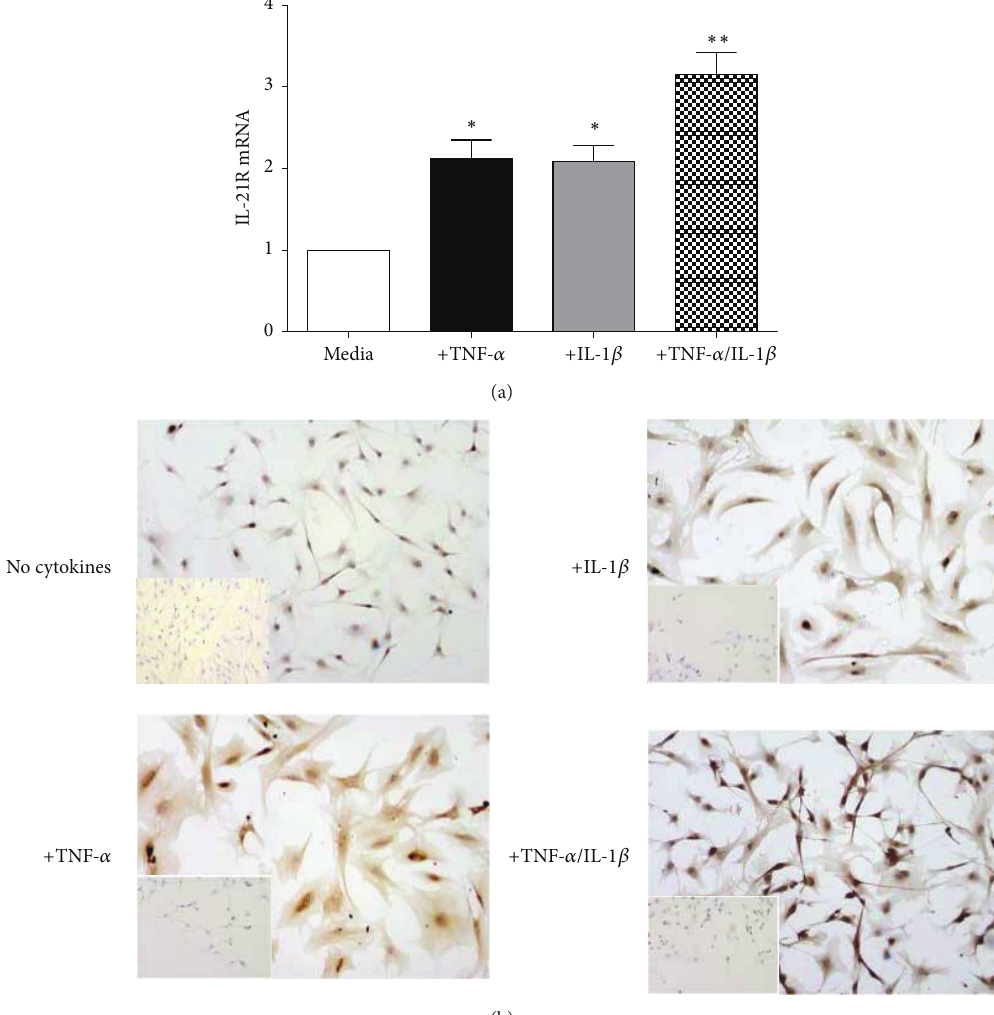
Figure 3: Upregulation of IL-21R in tenocytes in vitro . (a) The levels of mRNA ( 2 −ΔΔ CT ) for IL-21R were determined by real-time PCR in explanted tenocytes in vitro following stimulation with IL-1, TNF, and in combination. Data are shown as the mean fold change ± SD of triplicate samples compared to no stimulated cells corrected to GAPDH and are representative of experiments using five individual donors of tendon explant tissue. (b) Immunostaining for IL-21R in explant tenocyte cultures stimulated as in (a) confirming changes at protein